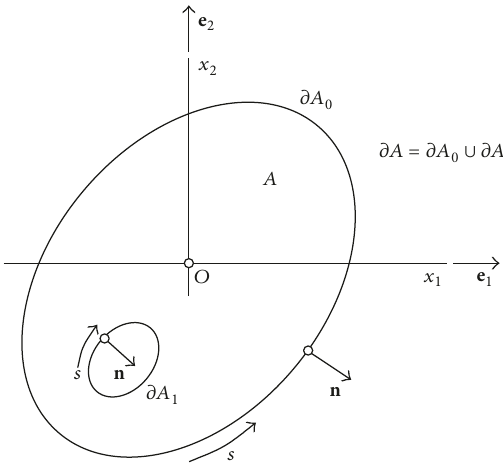
Figure 2: Cross-section and its